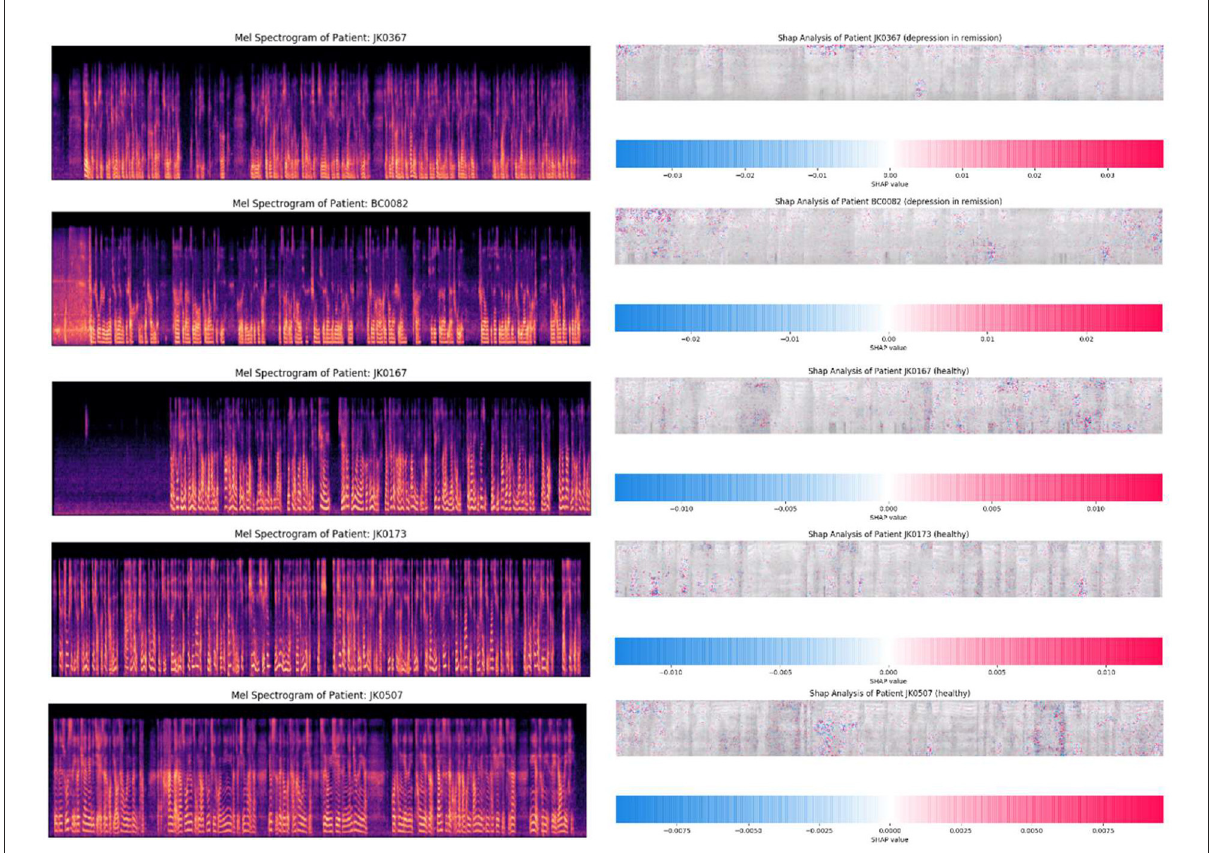
FIGURE5 The mel spectrogram of participants in remission. Participants whose ID are JK0167, JK0173, JK0507, and JK0367 were diagnosed with major depressive disorder in remission by reference standard, and the first three were classified as healthy people by the depression classifier, and the latter as